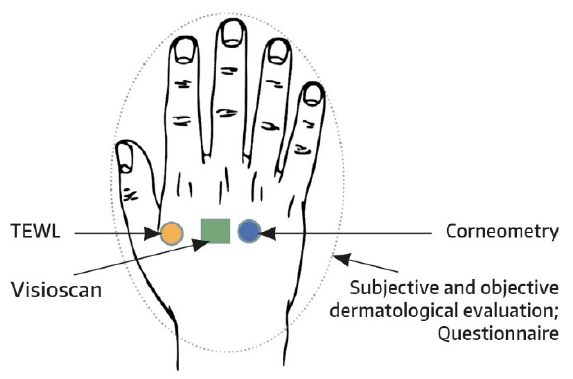
Figure 1. Scheme of the test areas using the right hand as an example.